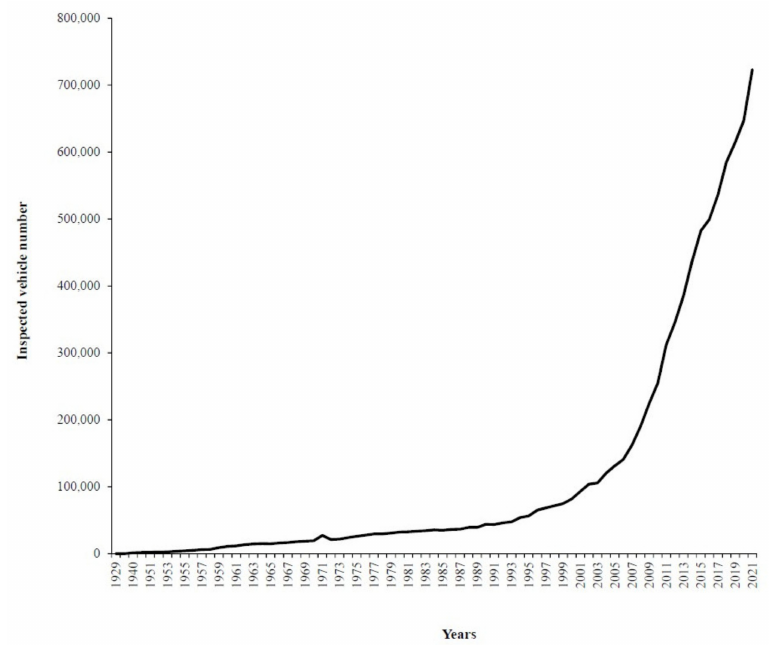
Figure 1. The number of annually inspected vehicles between 1929 and 2021 in Mongolia. All registered vehicles are legally required to be inspected annually. Therefore, the number of annually inspected vehicles could represent the number of registered vehicles in